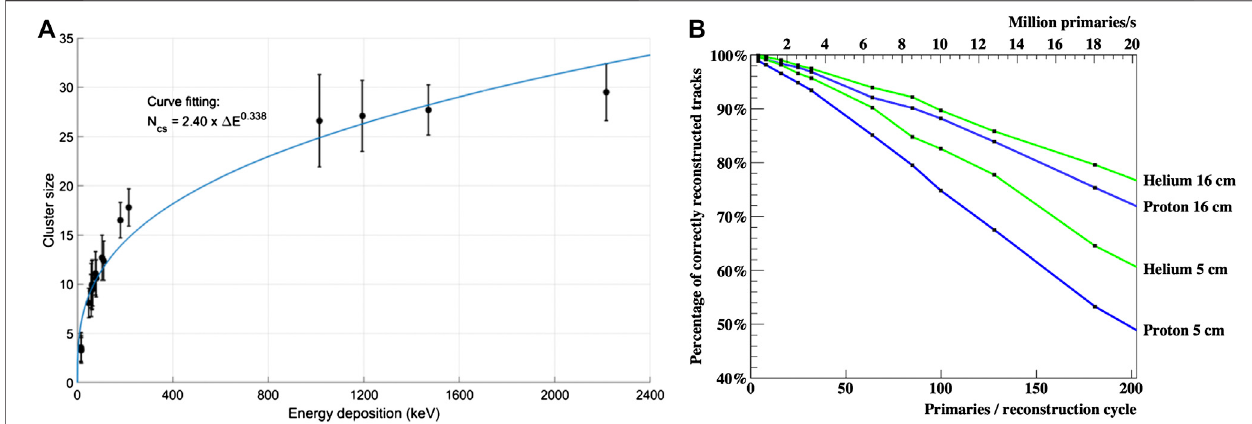
FIGURE11|(A) AplotoftheclustersizeasafunctionoftheenergydepositionintheepitaxiallayeroftheALICEpixeldetector(ALPIDE)chip.Theenergydeposition was evaluated through MC simulation, the cluster sizes are experimental point taken during the two experiments at the HIT facility. (B) Percentage of correctly reconstructedtracksforprotonandheliumprimariesfortwosimulatedwaterphantoms.Thenumberofprimariesperreconstructioncycleisthenumberofprimariesina Gaussian pencil beam with an FWHM of 7 mm. Two different imaged objects are shown with thickness of 5 and 16 cm.